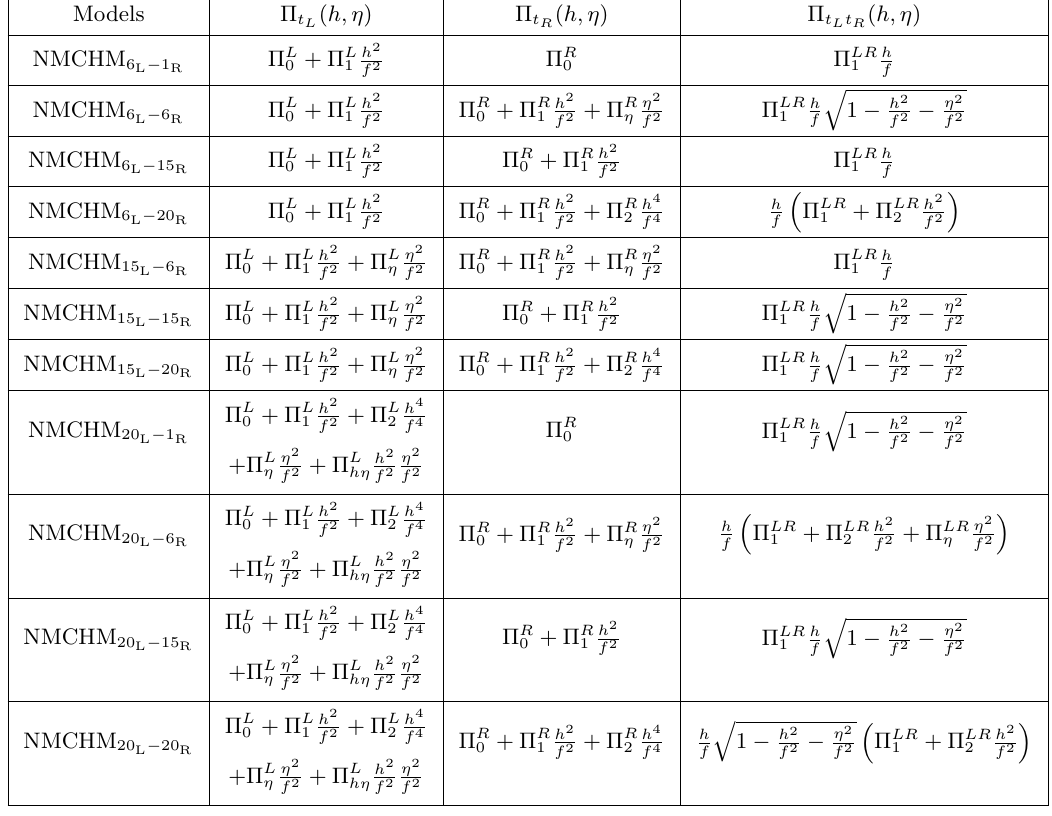
Table 4. List of (cid:5)-functions for di(cid:11)erent representations of next-to-minimal model.